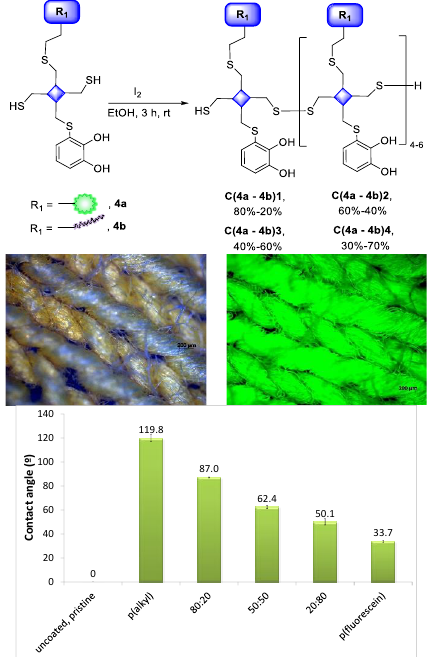
Figure 3. Top: Polymerization with the synthesized monomers 4a and 4 b, to obtain final copolymers with two main properties: fluorescence and hydrophobicity (Scale bar: 200 µ m). Middle: images from an optical/fluorescence microscope of cotton fibers coated with copolymer 80:20 ( 4b : 4a ) (left), and homopolymer p4a (right). Bottom: WCA values of coated cotton weaves with some copolymers and C8-9.